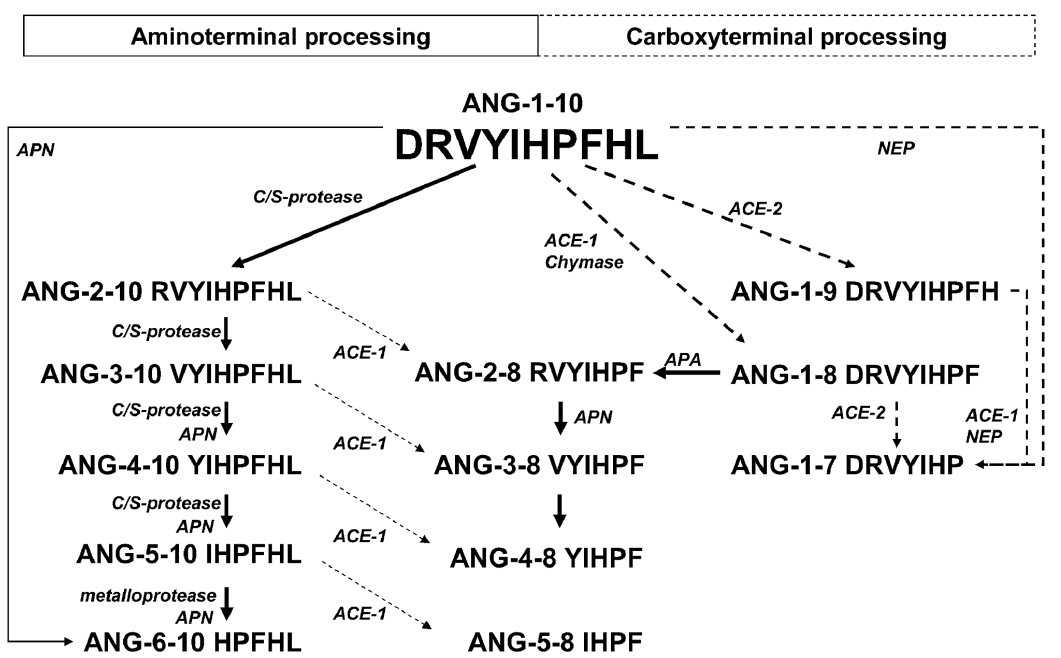
Figure 6. Overview of ANG-1-10 processing by human plasma proteins and by recombinant APN and ACE-1. Arrows with dashed lines indicate hydrolysis from C-terminus. N-terminal-processing is marked by arrows with continuous lines. APN: Aminopeptidase N. C/S-protease: cysteine/serine protease. ACE-1: Angiotensin converting enzyme-1, APA: Aminopeptidase A, NEP: Neprilysin.